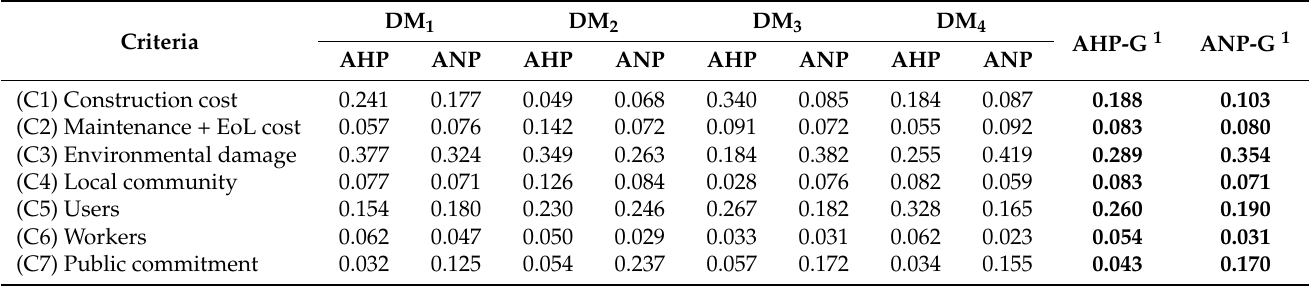
Table A3. Comparison of the weights for the seven criteria determined through AHP and